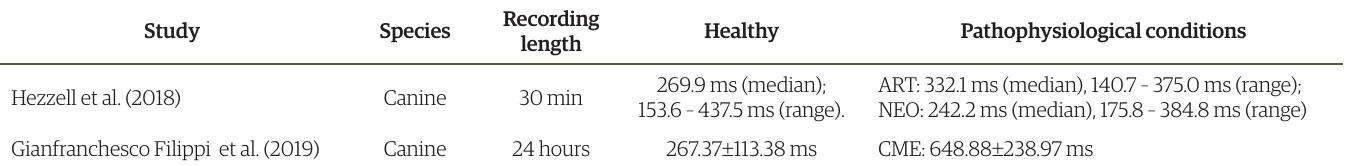
Table 6. Summary results of selected studies from the literature, depicting the recording length for data acquisition and the HTI values for healthy animals or those presenting pathophysiological conditions.